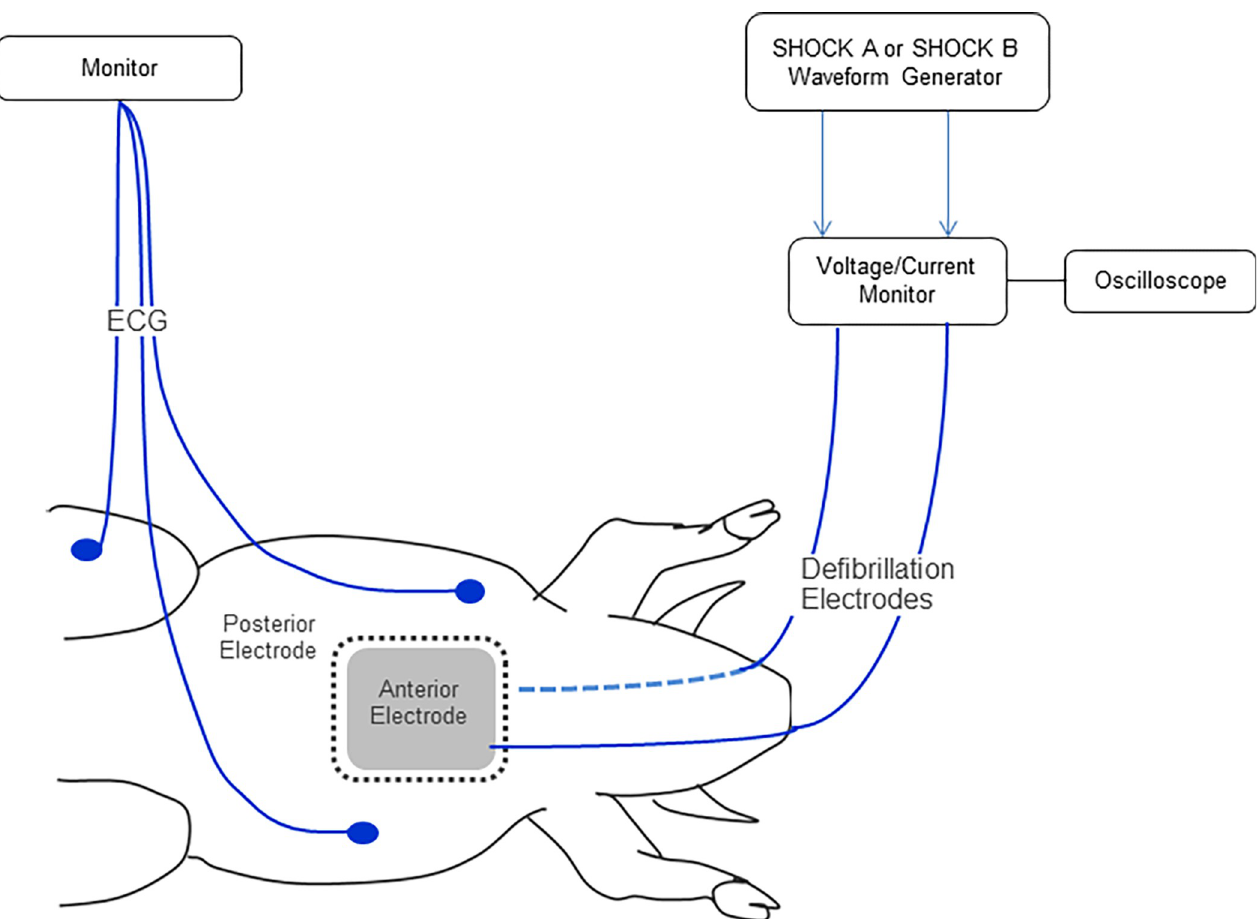
Fig 8. Animal Study #3 experimental setup. Image illustrating laboratory setup to enable shock delivery during normal sinus rhythm and monitoring in swine. ECG = Electrocardiogram.